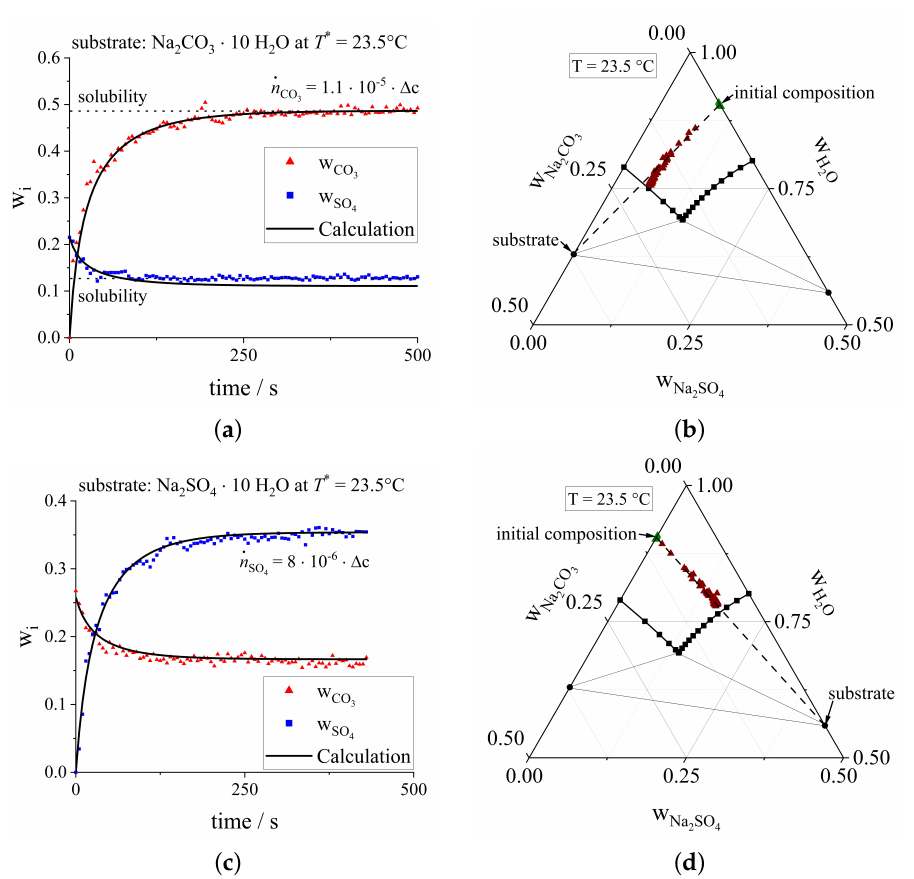
Figure 9. Diagrams ( a , b ) display the course of sodium carbonate decahydrate dissolution. In ( c , d ), the dissolution course of sodium sulfate decahydrate is illustrated. The given equations were used to calculate the solid lines. Initial concentrations (green triangles), substrate material (black circles), solubility (black squares/lines), and measured concentrations (brown triangles) are provided in the triangle diagrams on the